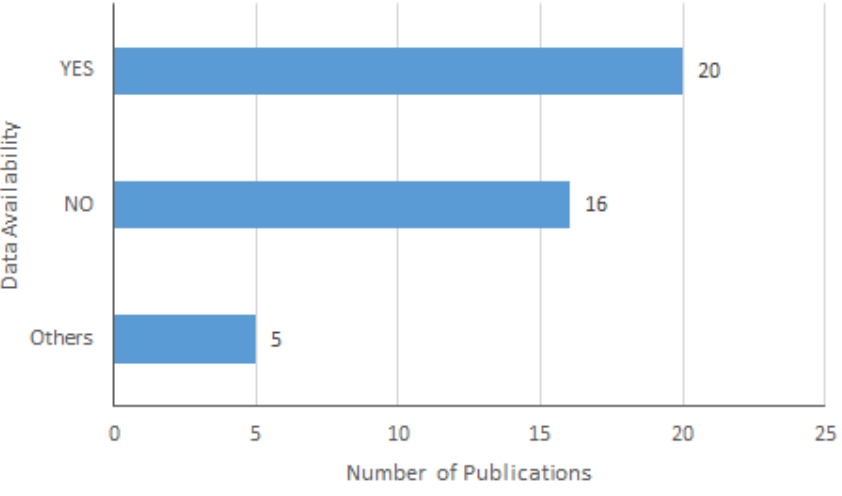
Figure 13. Data accessibility in the selected